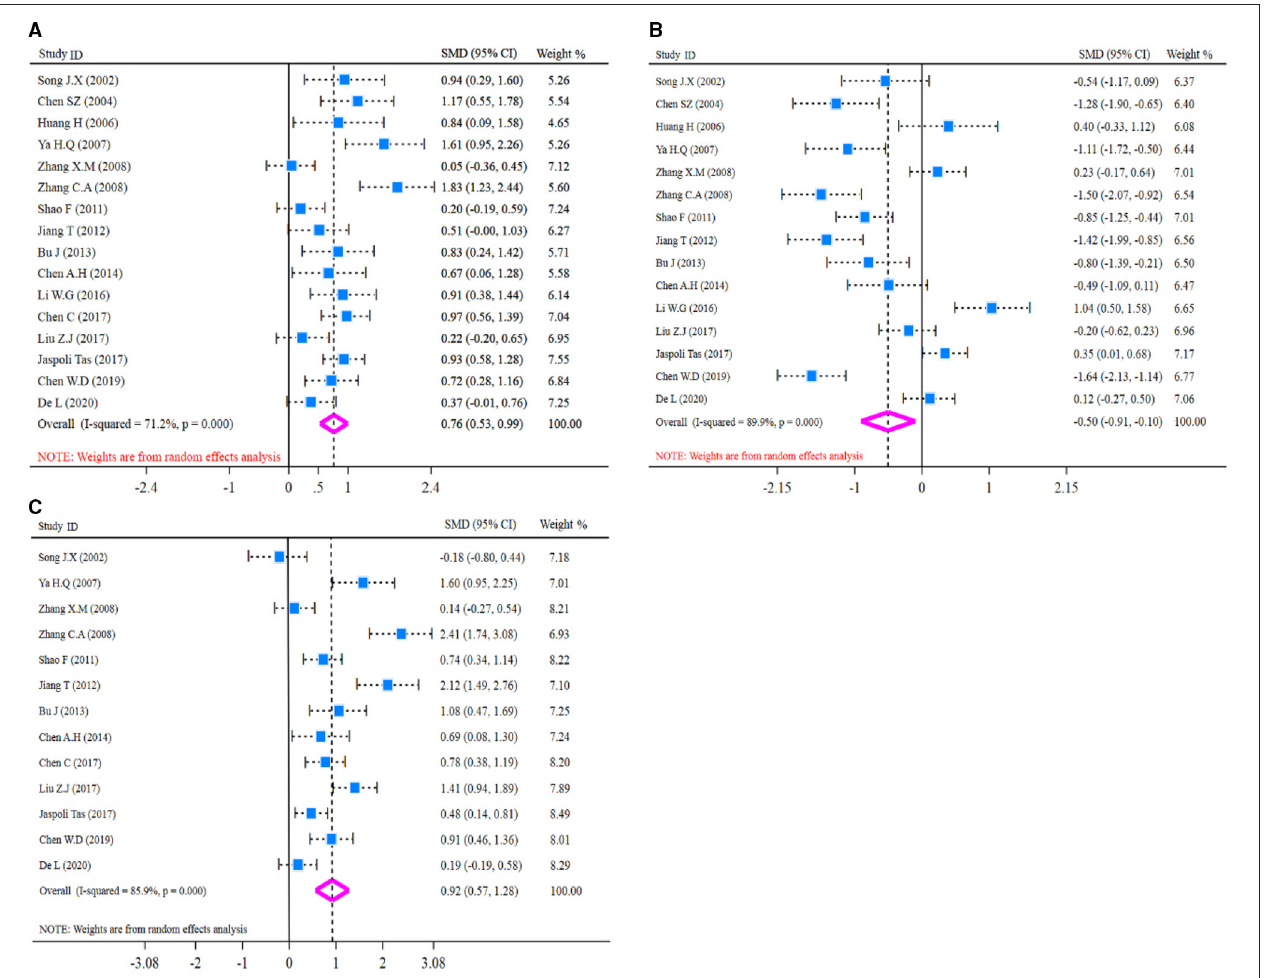
FIGURE 4 | Forest plot of standard mean difference (SMD) for CD4 + , CD8 + , and CD4 + /CD8 + . (A) Forest plot of CD4 + ; (B) Forest plot of CD8 + ; (C) Forest plot of CD4 + /CD8 + . All pooled analysis applied a random effect model.